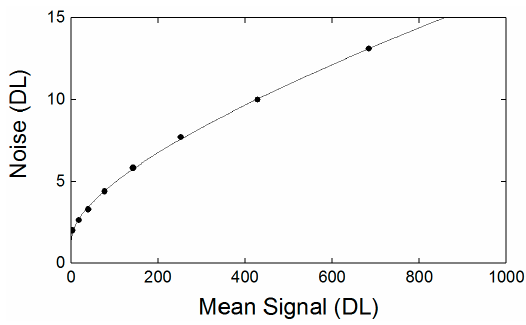
Figure 3. Digital level (DL) mean temporal noise levels plotted against signal, showing a near square root dependence, suggesting that the system is quasi-shot noise